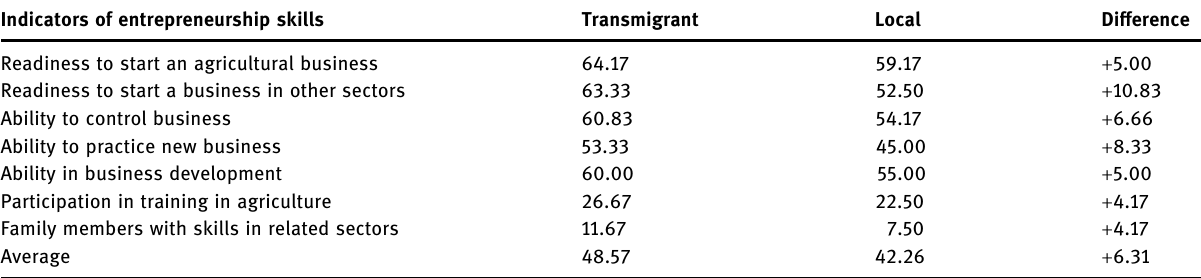
Indicators of entrepreneurship skills